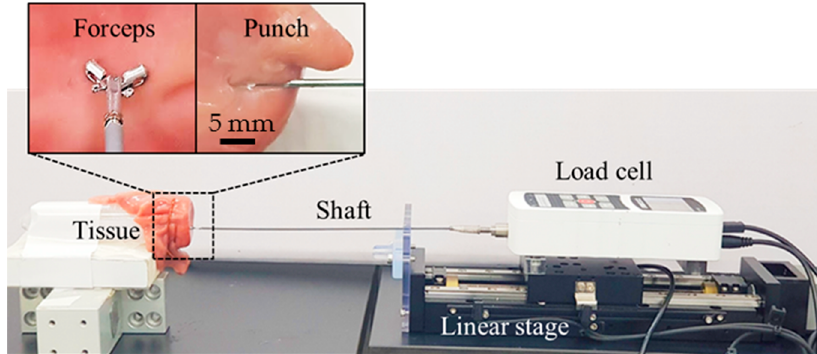
Figure 8. Experimental setup with commercial biopsy forceps and the biopsy punch.